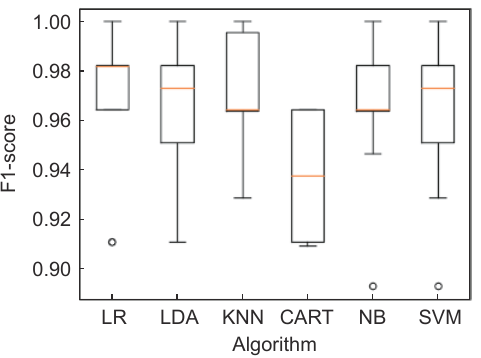
Fig. 3 F1-score of the conventional algorithms.